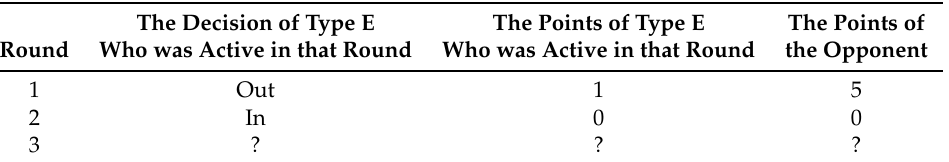
Table 2. An Example of a History Table of an